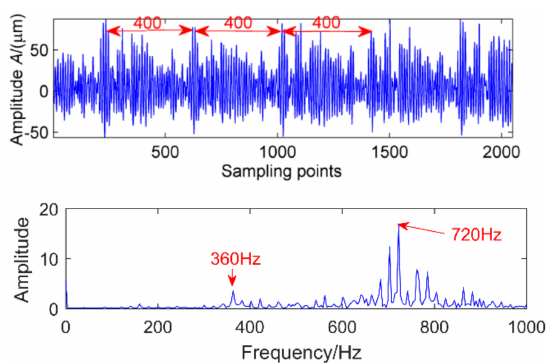
Figure 17. Gear pitting time domain waveform and Fourier spectra.